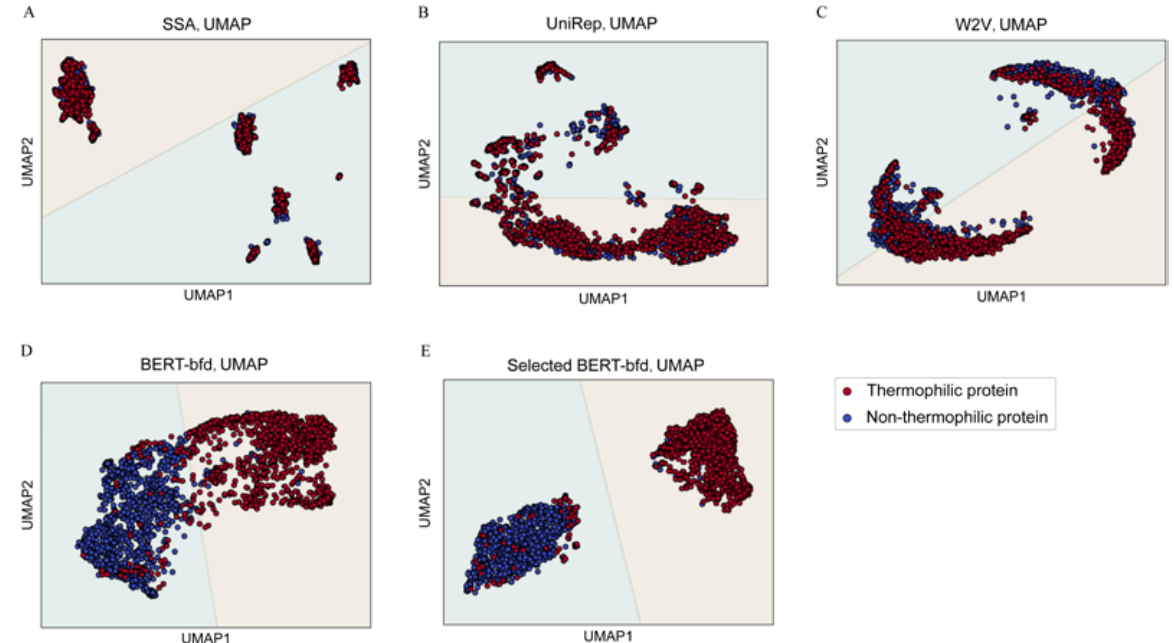
Figure 4. Dimension reduction visualization of BERT-bfd and other deep representation learning features. Red dots represent thermophilic proteins and blue dots represent non-thermophilic pro- teins. Horizontal axis and vertical axis are the first feature and the second feature of the reduced 2-dimensional vectors, respectively. These dots are classified by LR (yellow area for positive samples, while cyan area for negative samples). ( A ) shows the SSA feature reduced by UMAP. ( B ) shows the UniRep feature reduced by UMAP. ( C ) shows the W2V feature reduced by UMAP. ( D ) shows the BERT-bfd feature reduced by UMAP. ( E ) shows the selected BERT-bfd (top 90) feature reduced by UMAP.